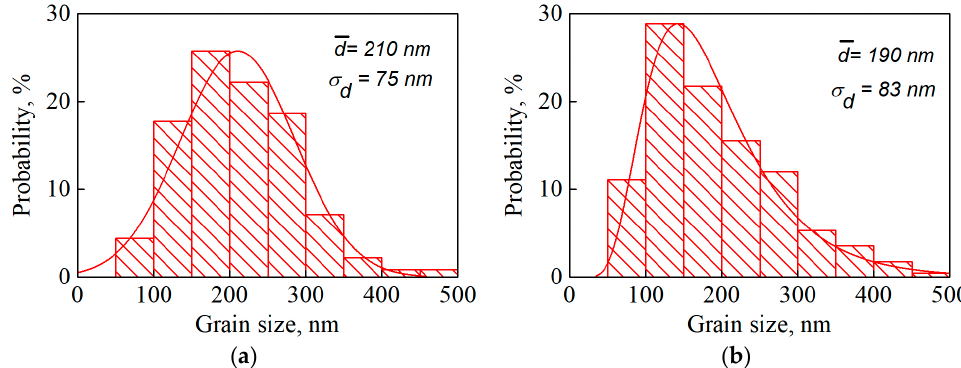
Figure 4. Dispersion of coating surface grain sizes for samples deposited under tilt angles of 0° ( a ) and 80° ( b ) at a working gas pressure of 0.8 mTorr.